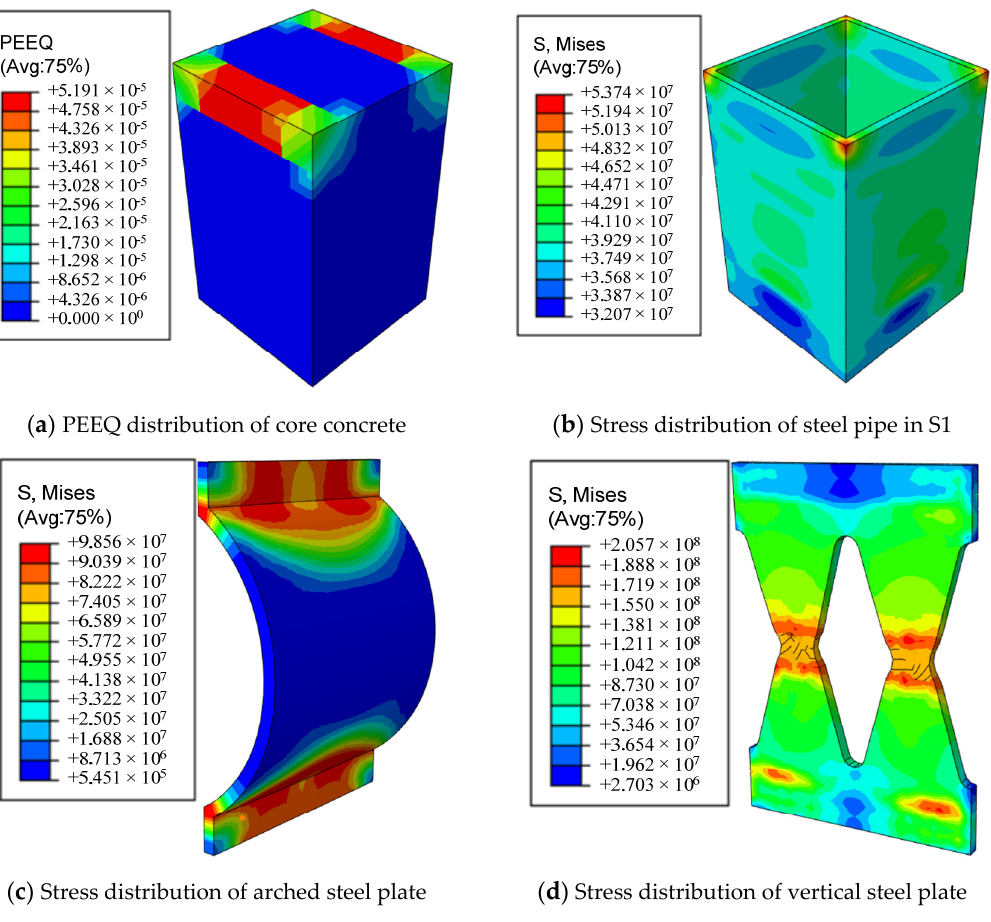
Figure 20. Stress distribution of PSCFSTBP with external